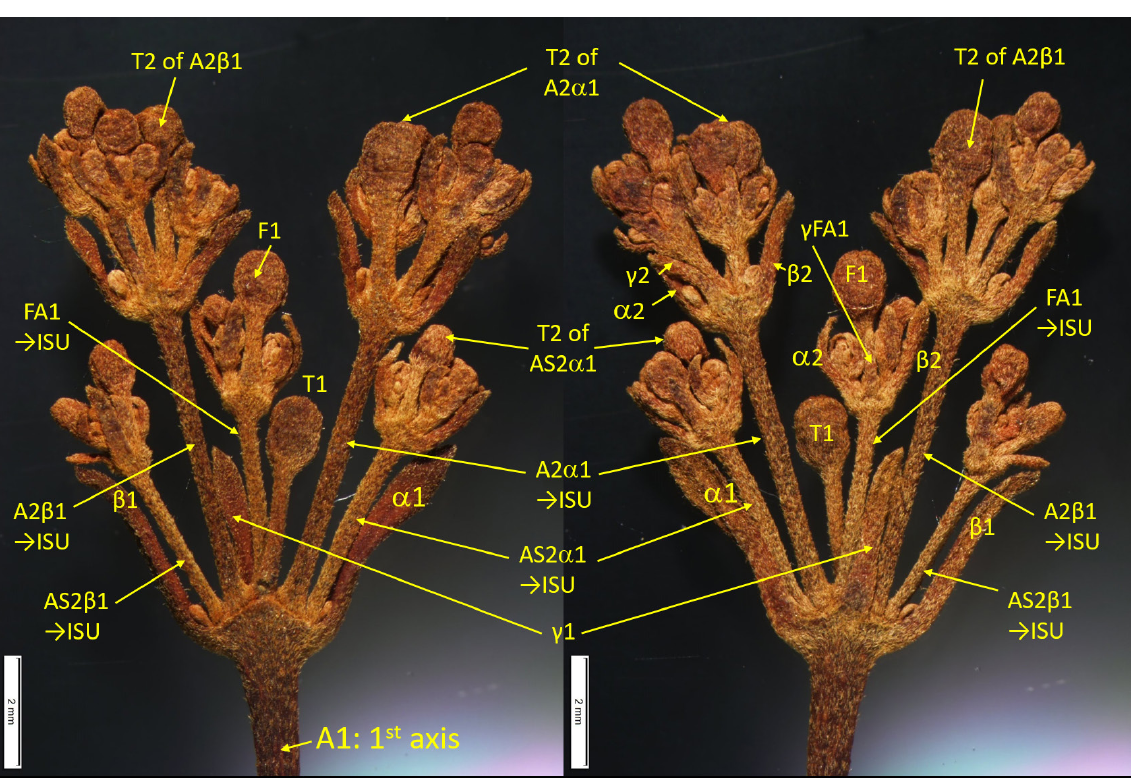
Fig. 6. Recto and verso photographs of a very young inflorescence of Bopopia parviflora Munzinger & J.R.Morel gen. et sp. nov